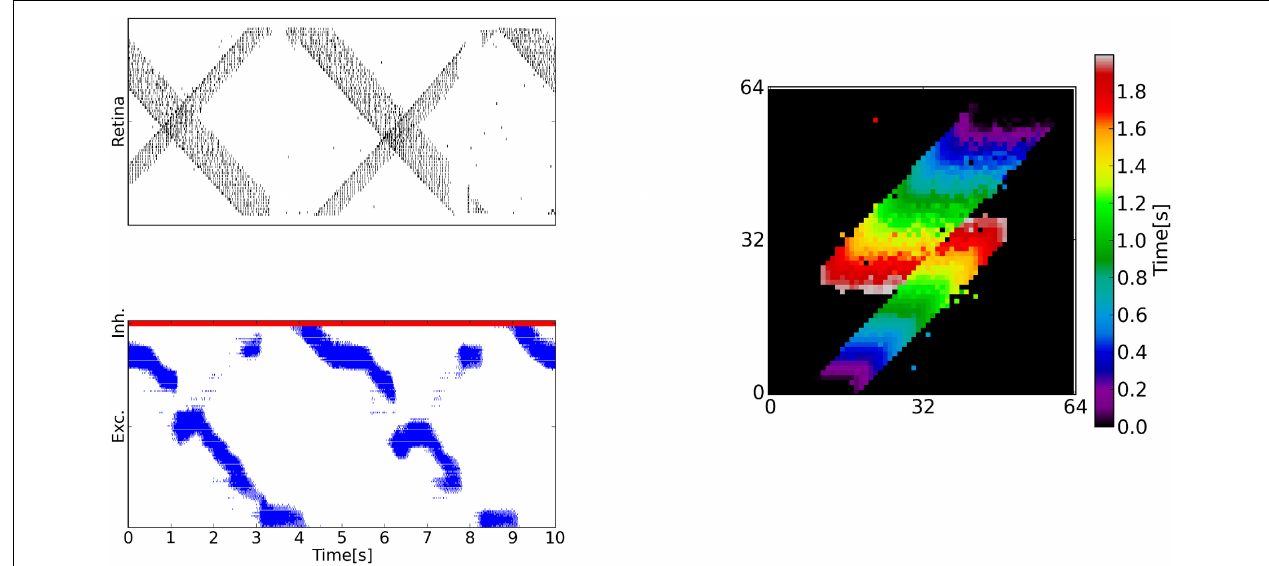
FIGURE 3 | A multi-neuron chip implementing the soft WTA function, interfaced with a silicon retina. Top left: Raster plots of the retina’s column–wise output activity. The pixel columns of the retina project on to the multi-neuron chip, such that each neuron received inputs from 2 columns. Bottom Left: Raster plot of the sWTA chip, where blue indicates the excitatory neuron events and red indicates inhibitory neuron events. The